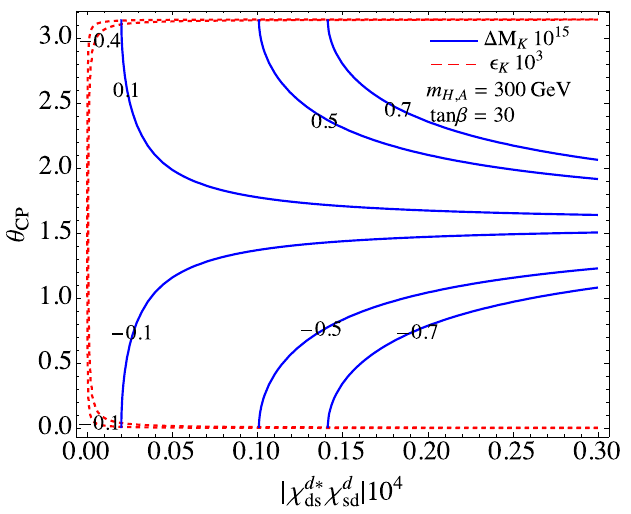
Figure 4 . Contours for the H=A -mediated (cid:1) M K (in units of 10 (cid:0) 15 ) and (cid:15) K (in units of 10 (cid:0) 3 ) as a function of (cid:31) d (cid:3) (cid:31) d scaled by 10 (cid:0) 4 and (cid:18) CP ds sd j j